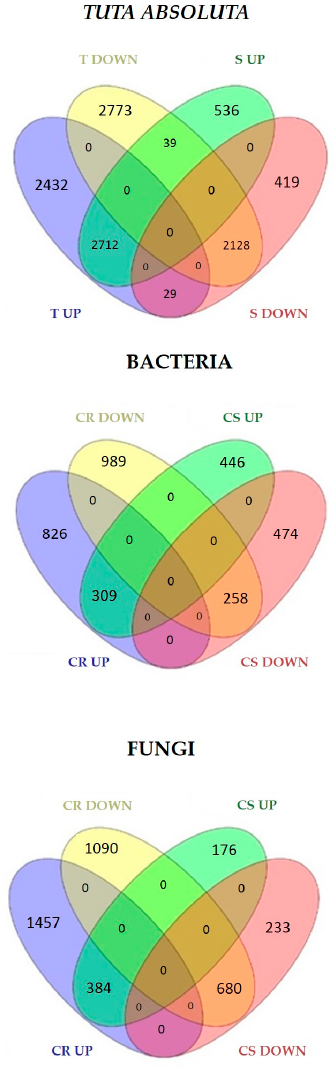
Figure 2. Private DEGs identified in R and S genotypes to fungi, bacteria, and Tuta absoluta . CR = common DEGs among R genotypes; CS = common DEGs among S genotypes; T = tolerant; S = susceptible genotypes.